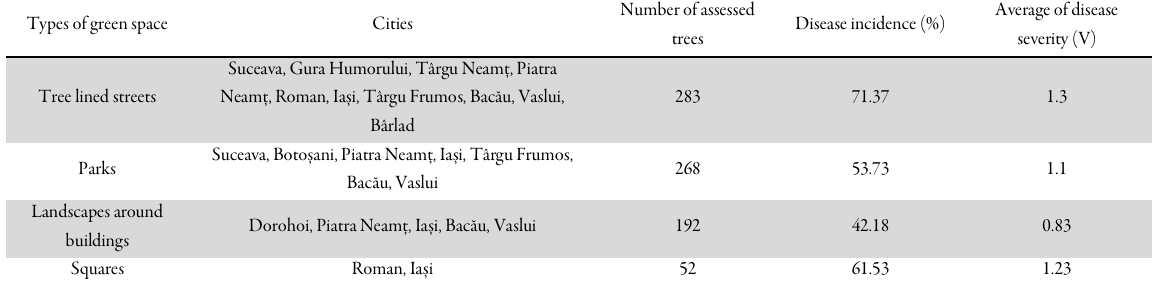
Table 1. Disease incidence and the average of disease severity within green spaces types investigated Types of green space